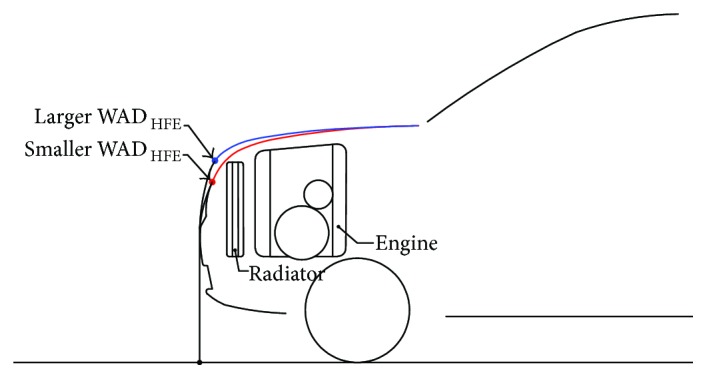
Schematic of a relatively long WADHFE and a relatively short WADHFE.